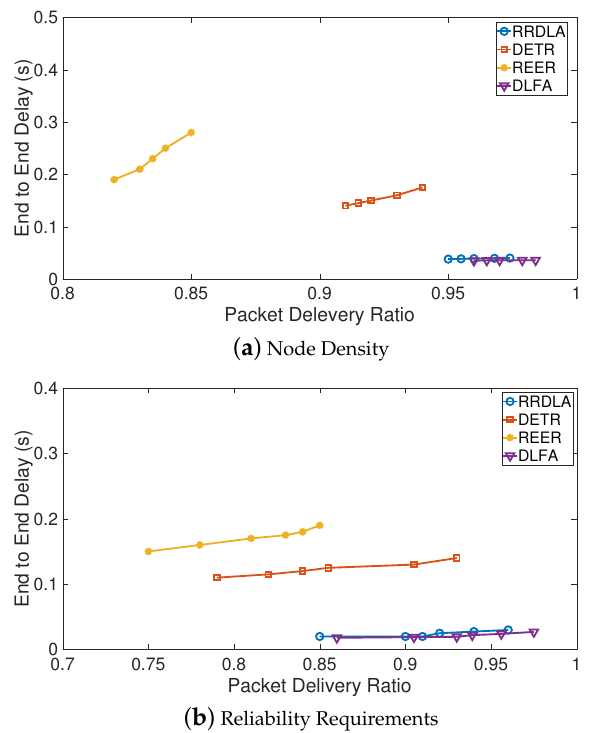
Figure 18. The simulation of the impact of the node density and quality of service, case end-to-end delay vs. packet delivery